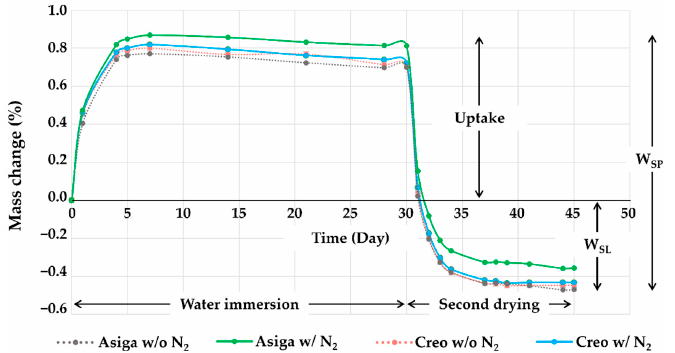
rougher microlayer structures in Asiga groups compared to Creo groups. The SEM images as well as the OP images revealed that the rougher surface with wavelike structures was obtained in Asiga groups compared to the Creo groups regardless of the post-curing method. However, no obvious difference was found between specimens post-cured with and without N 2 in both Asiga and Creo groups.